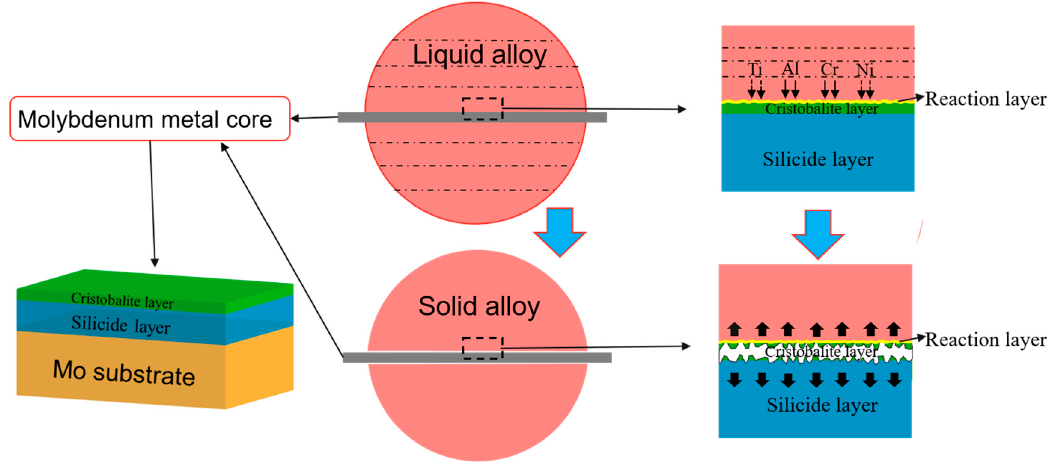
Figure 6. schematic diagram of the corrosion resistance of cristobalite layer during the cast process at 1550 ℃ .